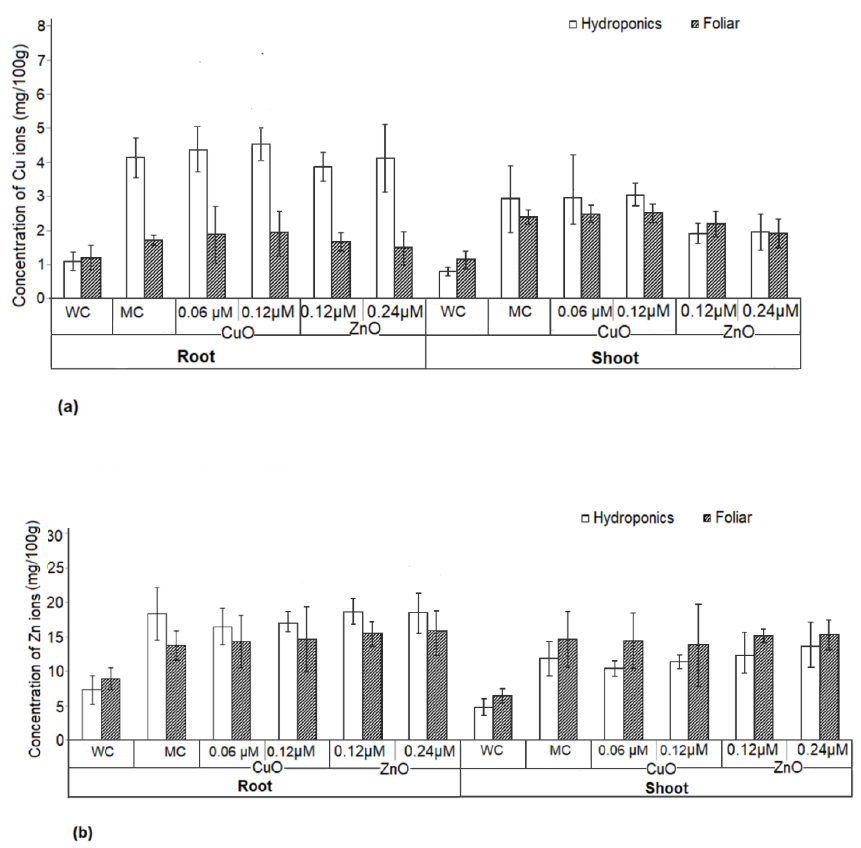
Figure 11. Uptake of ( a ) copper and ( b ) zinc in the roots and shoots of Amaranthus hybridus treated with varying concentrations of CuO and ZnO nanoparticles under hydroponics and foliar setups. A water control (WC) and media control (MC) were maintained. Significant difference ( p < 0.05).